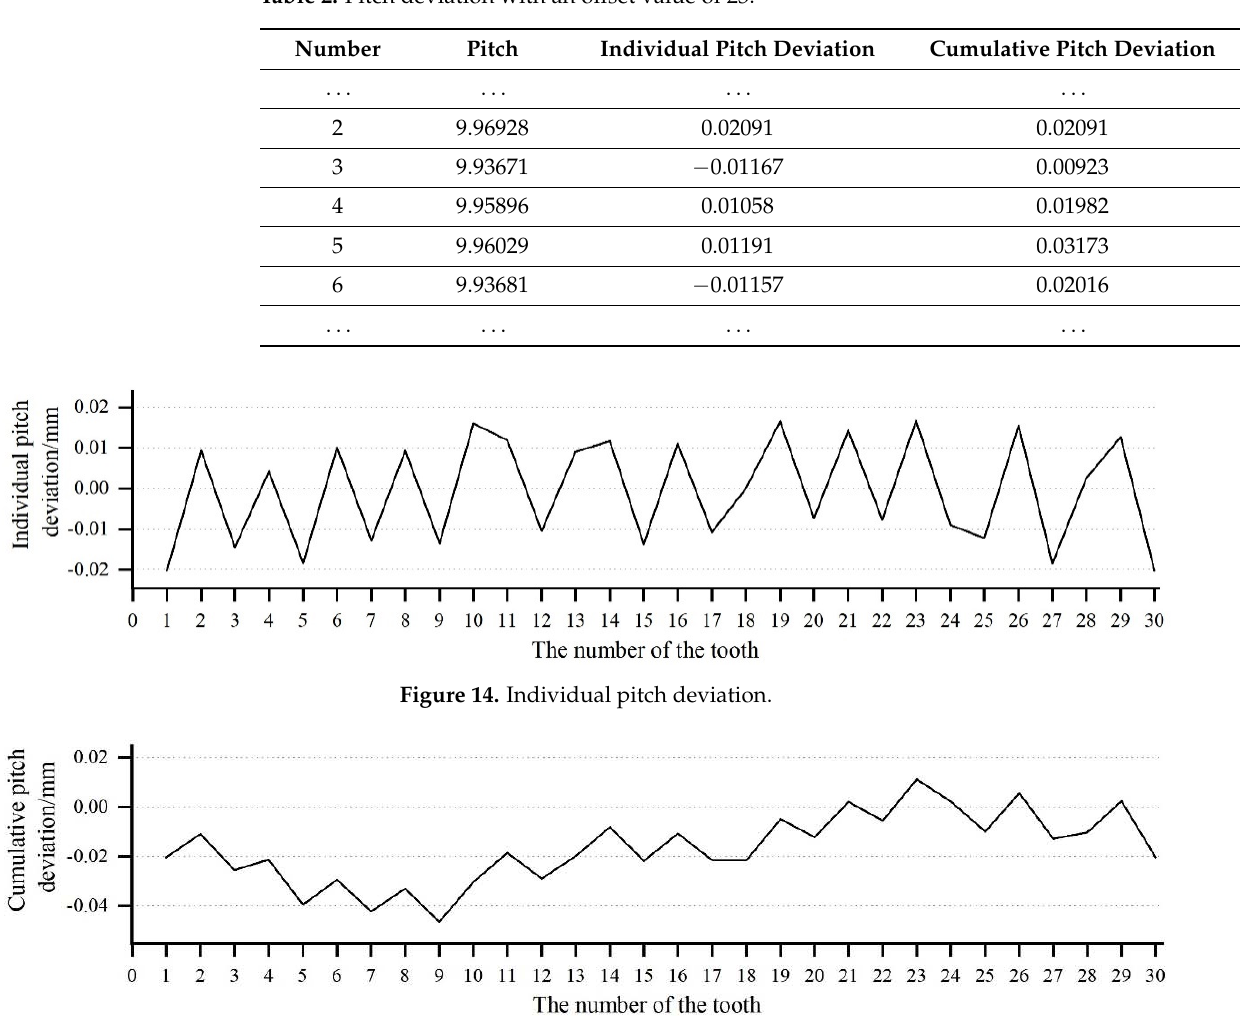
Figure 15. Cumulative pitch deviation.